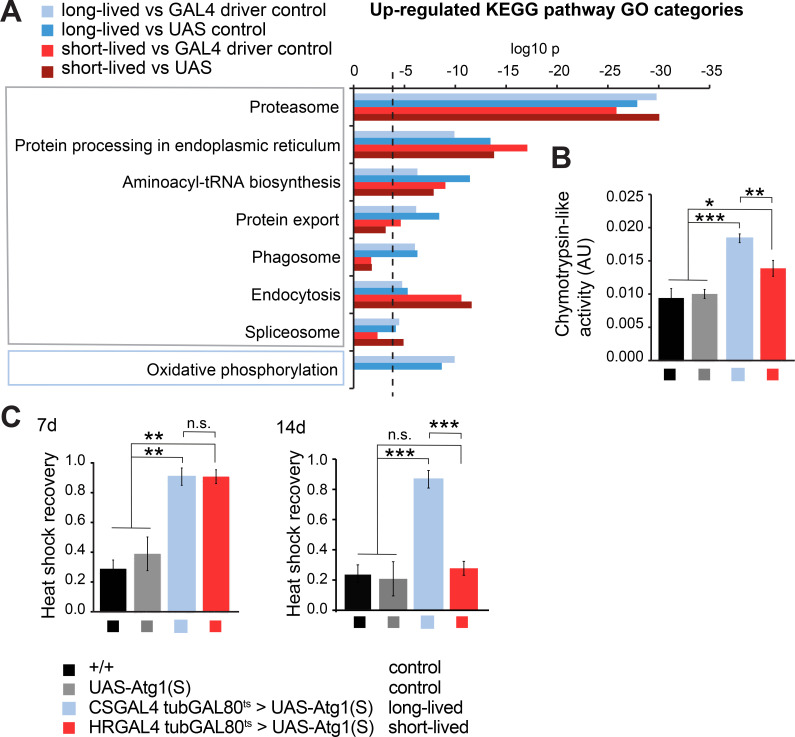
Transcriptomic analysis of the long-lived and short-lived Atg1 over-expressing lines reveals altered protein homeostasis (A) List of KEGG pathway GO categories that were up-regulated in the Atg1 over-expressing flies. Similar changes were observed in both mild and strong Atg1 over-expressing, with the exception of oxidative phosphorylation, which was up-regulated only in the long-lived flies having mild Atg1 up-regulation. (B) Proteasome activity was up-regulated in both Atg1 over-expressing flies (chymotrypsin-like, LLVY substrate). Data are means ±SEM of n = 10 replicates. Statistical significance was calculated by one-way ANOVA Student’s t-test (*, p<0.05; **, p<0.01; ***, p<0.001). (C) Resistance of 7-day old (left panel) and 14-day old (right panel) flies to heat shock stress, determined as the proportion of flies recovering after 35 min at 39°C. Improved heat shock resistance was observed in both long-lived and short-lived Atg1 over-expressing flies compared to controls for 7-day old flies. Data are means ±SEM of n = 3 samples with 15 flies each. Statistical significance was calculated by one-way ANOVA Student’s t-test (n.s., p>0.05; **, p<0.01). In 14-day old flies, the improved heat shock resistance was maintained in the long-lived autophagy flies, but lost in the short-lived (n.s., p>0.05; ***, p<0.001).